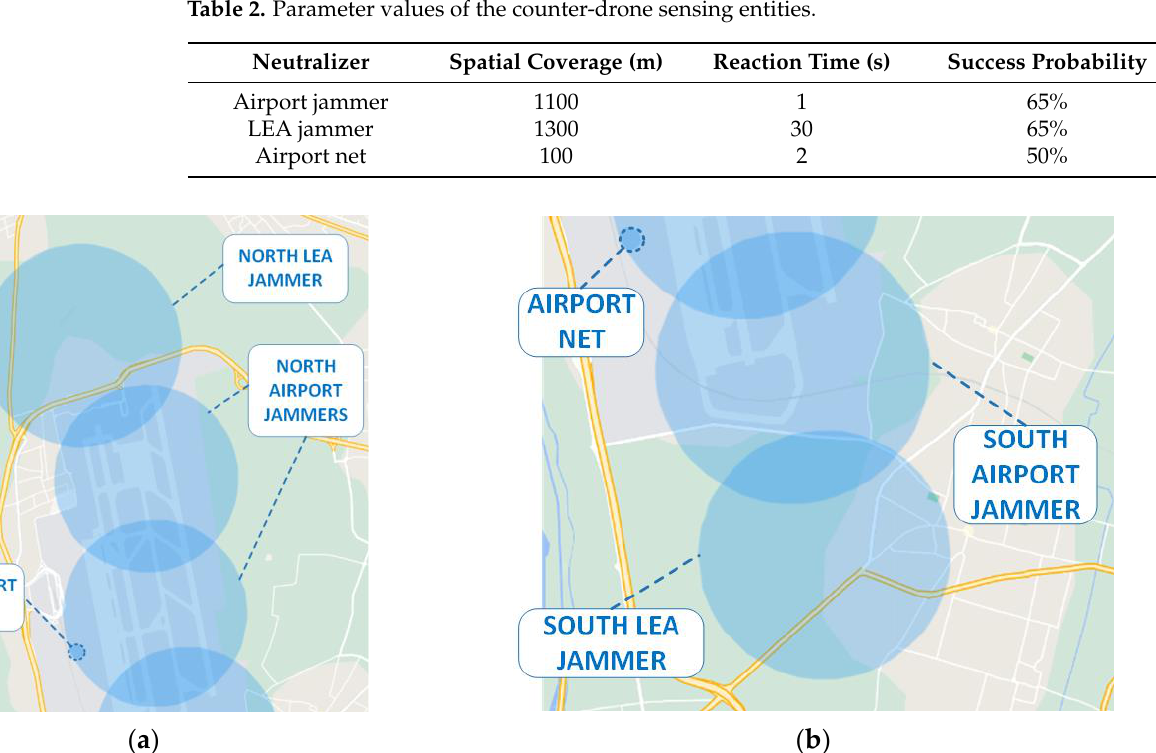
Figure 14. Displacement of counter-drone neutralization entities for solution scenarios. ( a ) North part of LIMC. ( b ) South part of LIMC. part of LIMC. ( b ) South part of